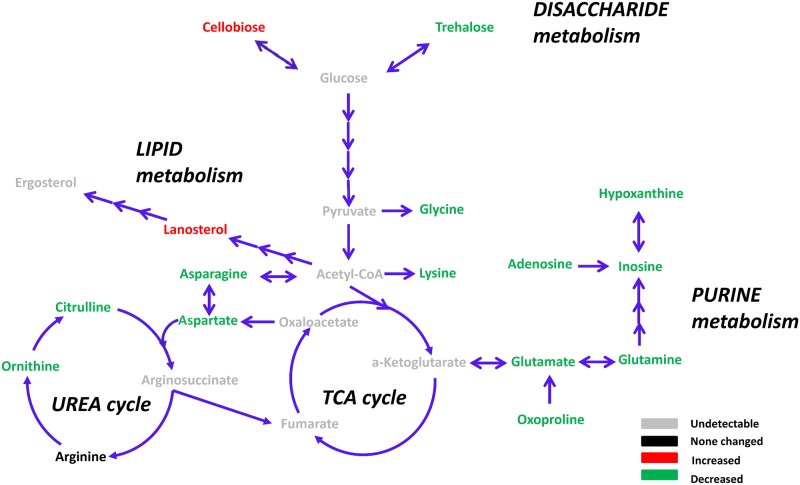
Resveratrol Modulates the Cell Metabolome.Intracellular pool sizes of metabolic intermediates in the TCA cycle, urea cycle, glycolysis, lipid metabolism pathway, disaccharide metabolism pathway and purine metabolism pathway. Grey fonts represent the undetectable metabolites. The black font represents the unchanged metabolites. The red font represents the significantly increased metabolites (increased pool size>50%, p-value<0.05), and the green font represents the significantly decreased metabolites (decreased pool size>50%, p-value<0.05). The quantitated pool size changes are indicated in Table 3.